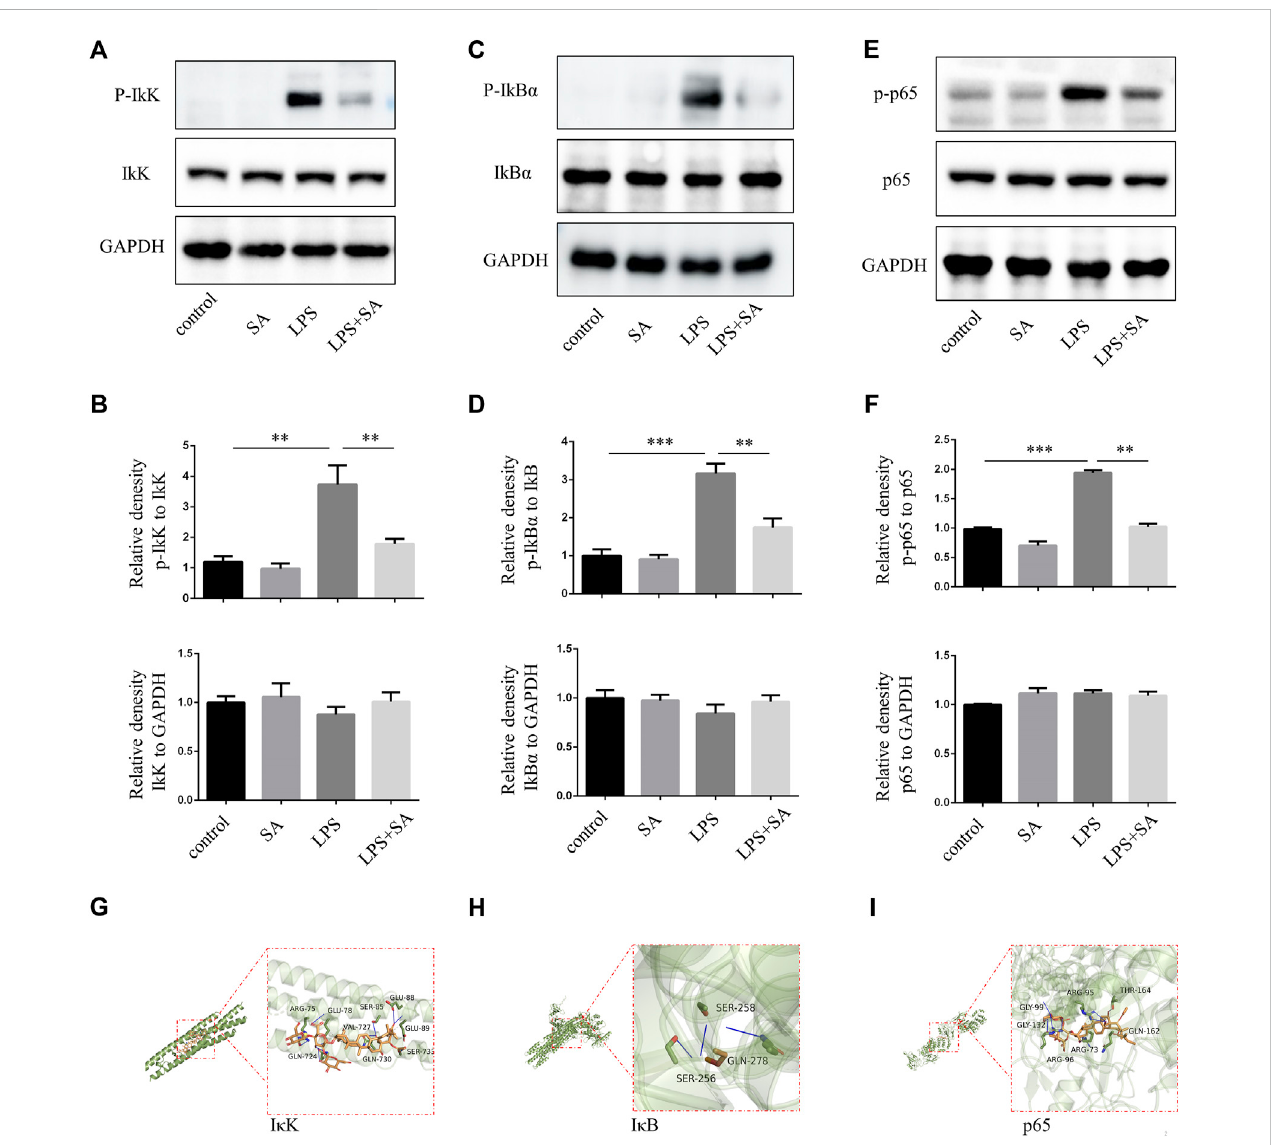
FIGURE 2 SA inhibited NF- κ B activation of BV2 induced by LPS. (A – F) BV2 cells were pretreated with SA for 12 h. After 15 min with LPS (100 ng/mL), the proteins were extracted and the protein levels of I κ K, p-I κ K, I κ B, p-I κ B, p65, and p-p65 were measured by western blot assay. (G – I) Molecular docking of active compound SA and core genes I κ K, I κ B, p65. Date are presented as mean ± SD,** p < 0.01, *** p < 0.001, n = 3 per